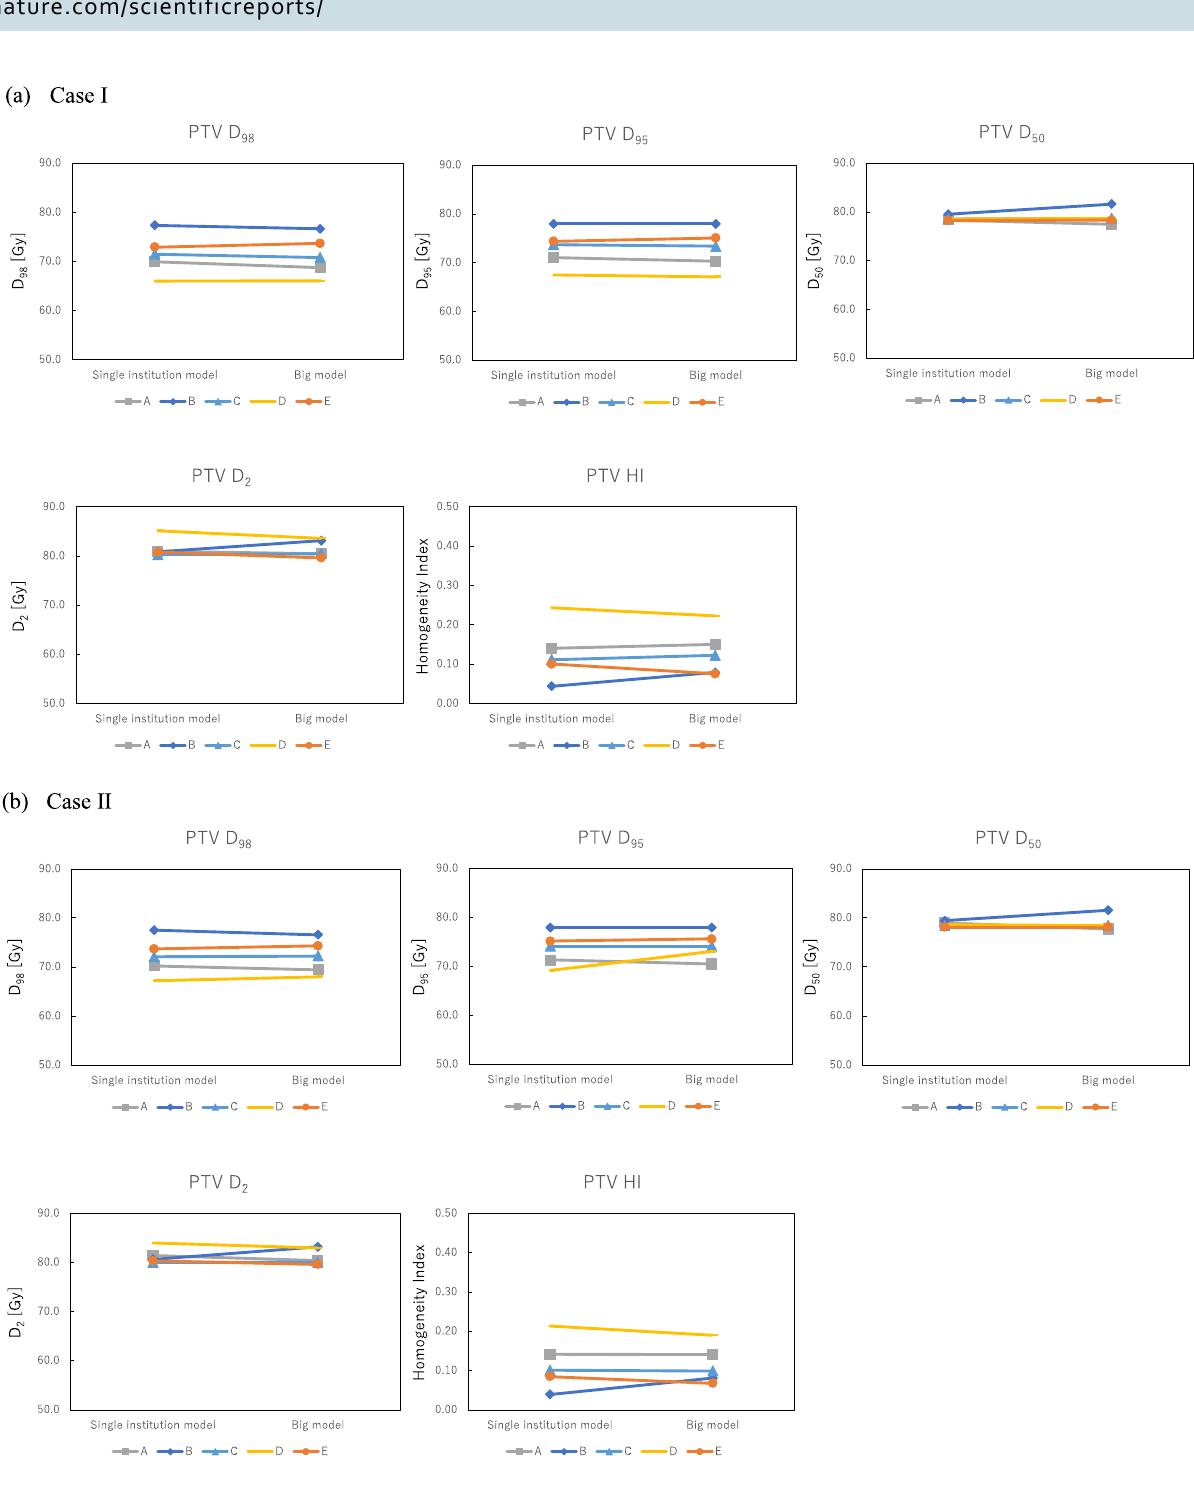
Figure 1. Dosimetric parameters for the ( a , b ) PTV, ( c ) rectum, and ( d ) bladder. For PTV, there were small differences between the single-institution models and big model in each case. Dosimetric parameters for the rectum calculated using the big model were lower than those calculated with the single-institution model. The volume ratio receiving 50% of the prescribed dose (V 50 ) for institution D had the maximum difference (37.2%) between the big model and single-institution model. For the bladder, the dosimetric parameters calculated with the big model were lower than or equivalent to those calculated with the single-institution model, except for institution